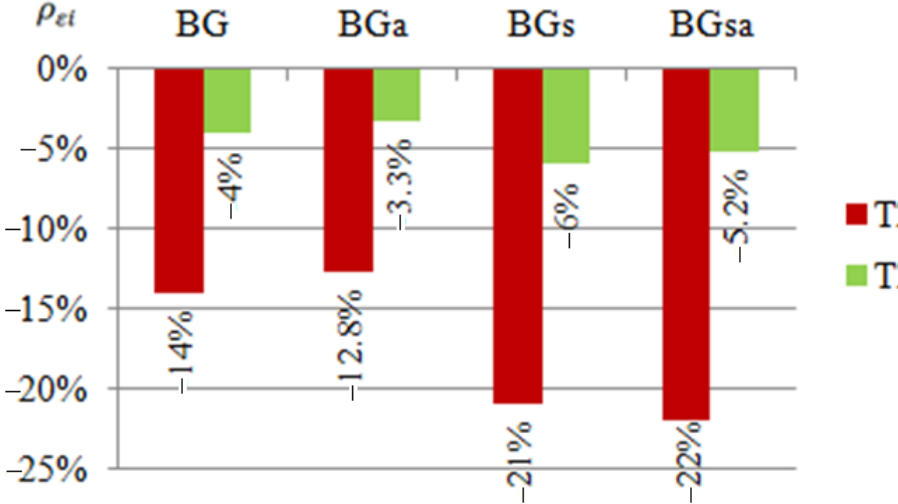
Figure 9. Percentage limits of deformation of reinforced beams in the upper flange.